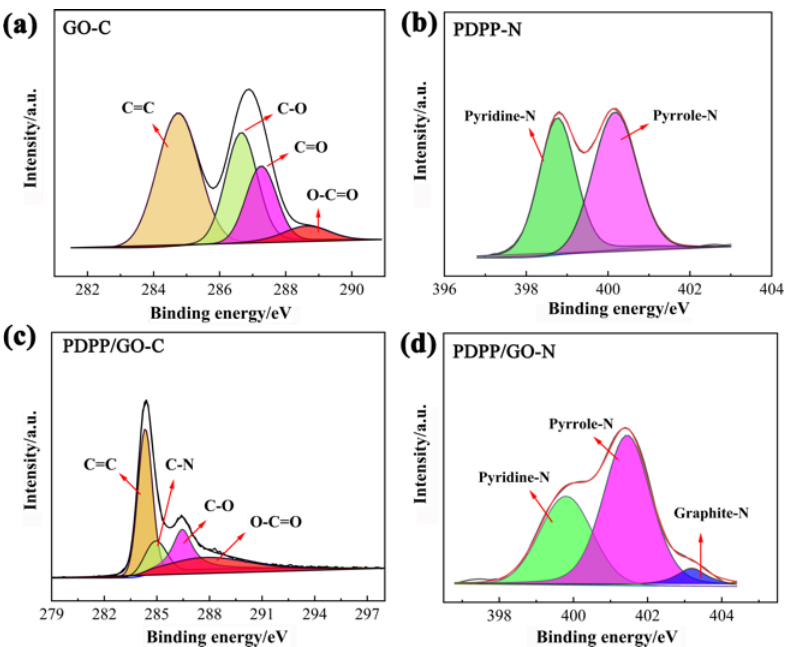
Figure 3. XPS spectrum of GO with C1s ( a ), PDPP with N1s ( b ), and PDPP/GO with C1s ( c ), N1s ( d ).